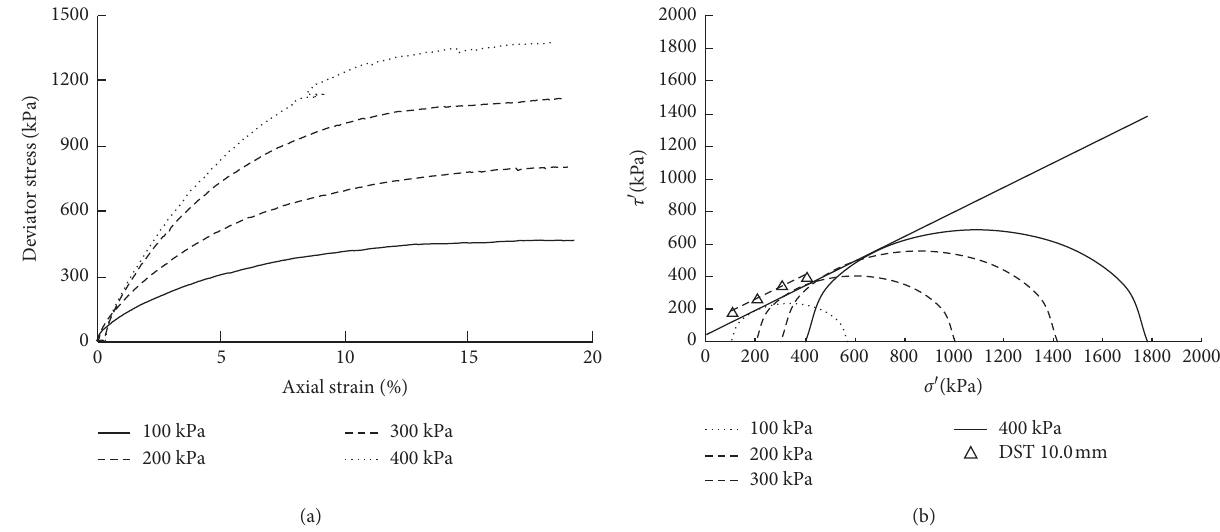
Figure 13: (a) Variation of deviatoric stress with axial strain for G2. (b) Comparison of shear strengths determined by direct shear test (plate opening 10.0mm) and triaxial tests for